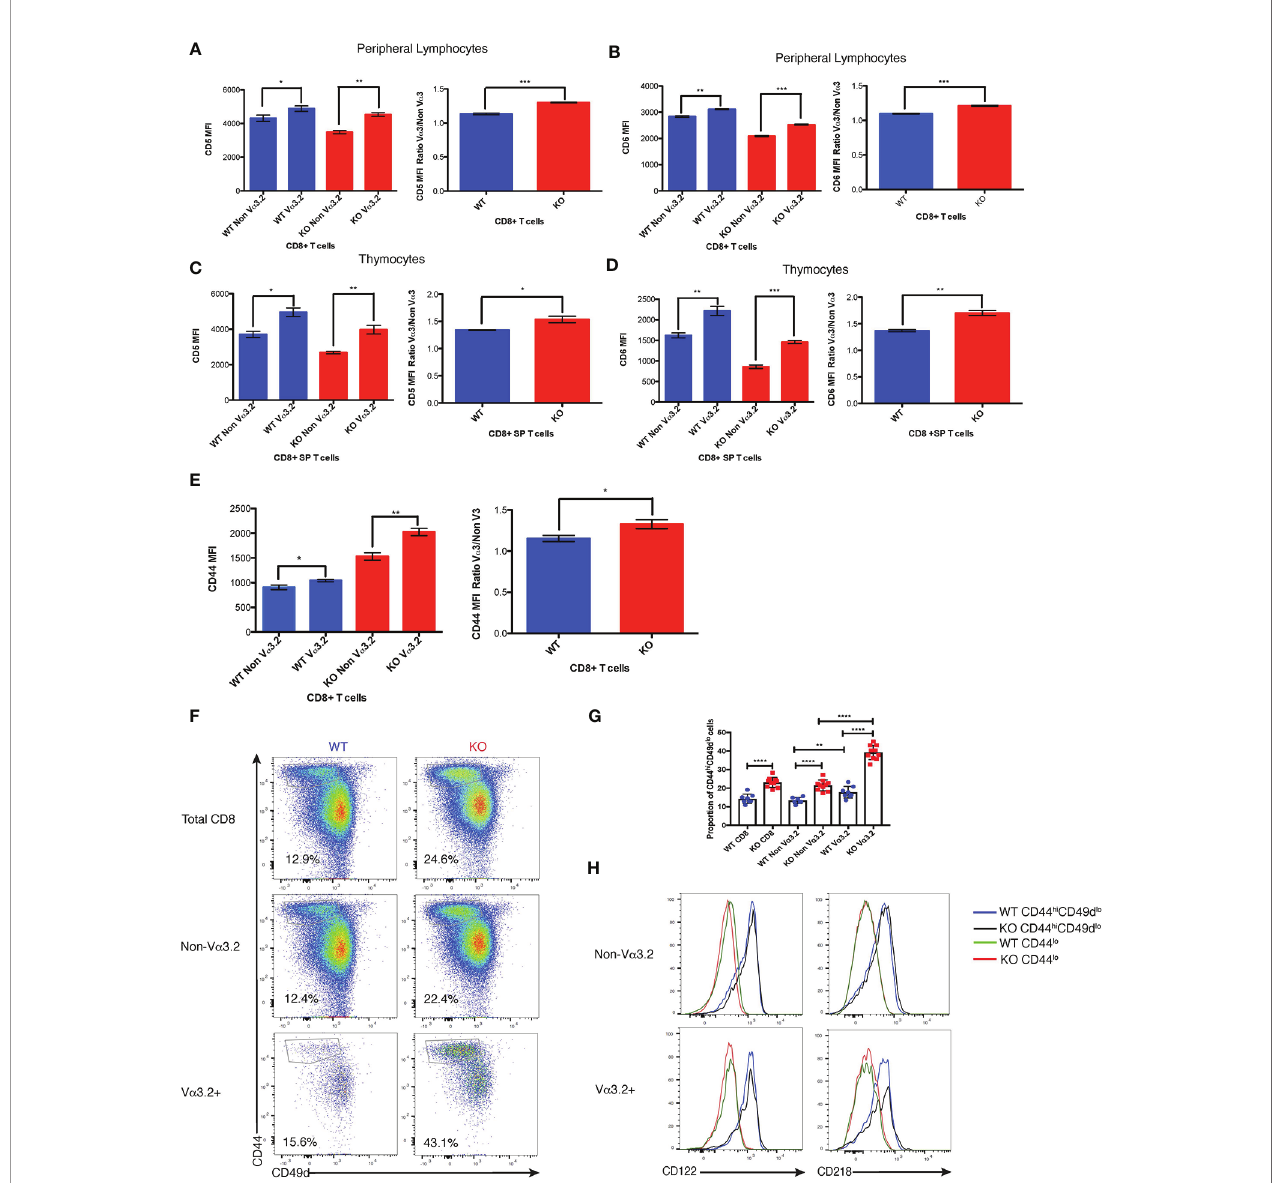
FIGURE 3 | Phenotypic pro fi le of V a 3.2 + CD8 + T cells in Themis – / – and Themis +/+ mice. (A) CD5 expression on V a 3.2 + and non-V a 3.2 + CD8 + T cells in the periphery of Themis – / – and Themis +/+ mice. (B) CD6 expression on V a 3.2 + and non-V a 3.2 + CD8 + T cells in the periphery of Themis – / – and Themis +/+ mice. (C) CD5 expression on V a 3.2 + and non-V a 3.2 + CD8 + SP thymocytes from Themis – / – and Themis +/+ mice. (D) CD6 expression on V a 3.2 + and non-V a 3.2 + CD8 + SP thymocytes from Themis – / – and Themis +/+ mice. (E) CD44 expression on V a 3.2 + and non-V a 3.2 + CD8 + T cells in the periphery of Themis – / – and Themis +/+ mice. (F) Representative FACS plots for CD44 vs CD49d staining in CD8 + T cells in the periphery of Themis – / – and Themis +/+ mice. (G) Bar plots showing summary of proportion of CD44 hi CD49d lo cells in CD8 + T cells in the periphery of Themis – / – and Themis +/+ mice. (H) Histogram of CD122 and CD218 staining in CD44 hi CD49d lo vs CD44 lo populations of V a 3.2 + and non-V a 3.2 + CD8 + T cells in the periphery of Themis – / – and Themis +/+ mice. Data are representative of three independent experiments with 4-5 biological replicates per genotype per experiment. *p < 0.05, **p < 0.01, ***p < 0.001, ****p < 0.0001 as determined by two-sided Student ’ s t- test. All error bars represent